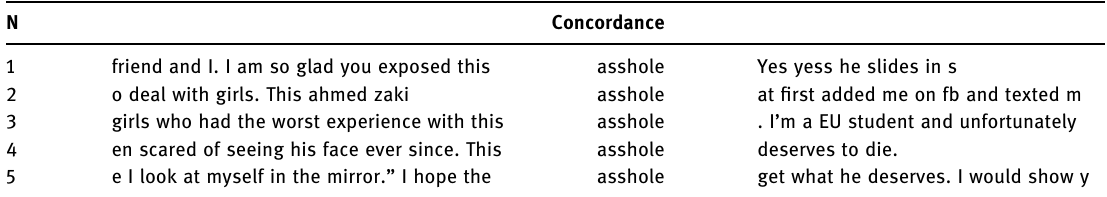
Table 13: Concordance lines for asshole